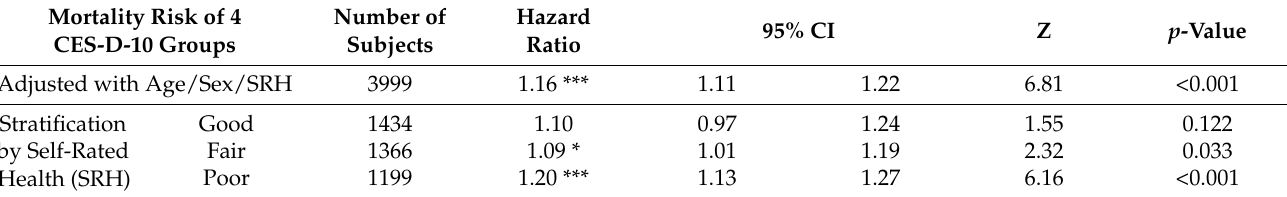
Table 3. Hazard Ratio in change of every CES-D Score in Group, stratified by SRH